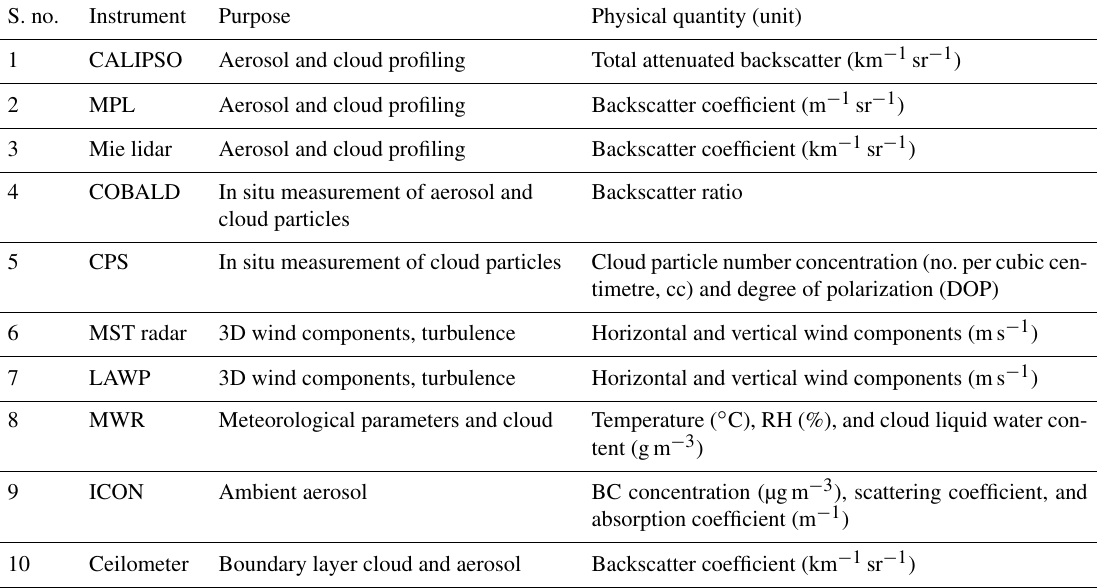
Figure 1. Schematic diagram showing the observational concept of the Balloon-borne Aerosol–Cloud Interaction Studies (BACIS) campaign. Table 1. List of instruments deployed (in BACIS) and the corresponding physical parameters obtained. S.